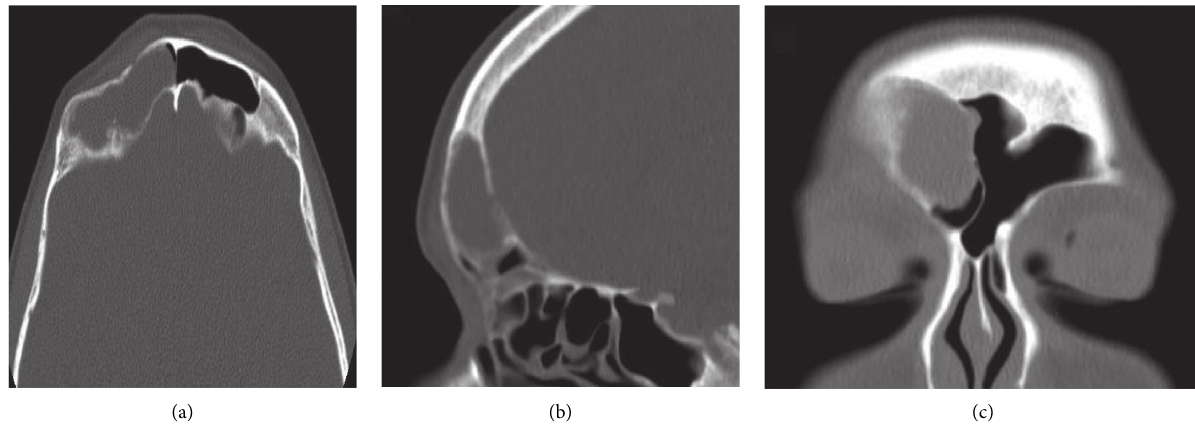
Figure 2: Computed tomography of paranasal sinuses in a bone algorithm in axial (a), sagittal (b), and coronal (c) planes. Right frontal sinus lesion with depressed fracture of the anterior wall and resorption of the lateral and posterior walls.